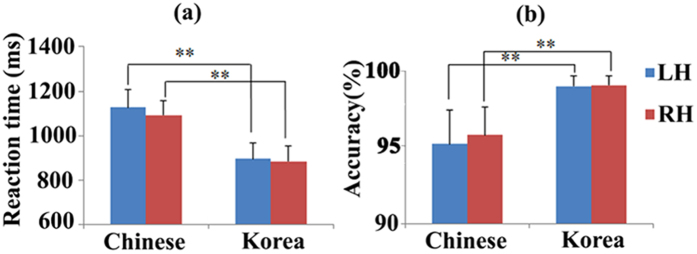
The behavioral performances in the two conditions.(a) Reaction time; (b) Accuracy. Error bars indicate standard deviation measurement. LH: Left handers; RH: Right handers. (**: significant threshold p < 0.01).